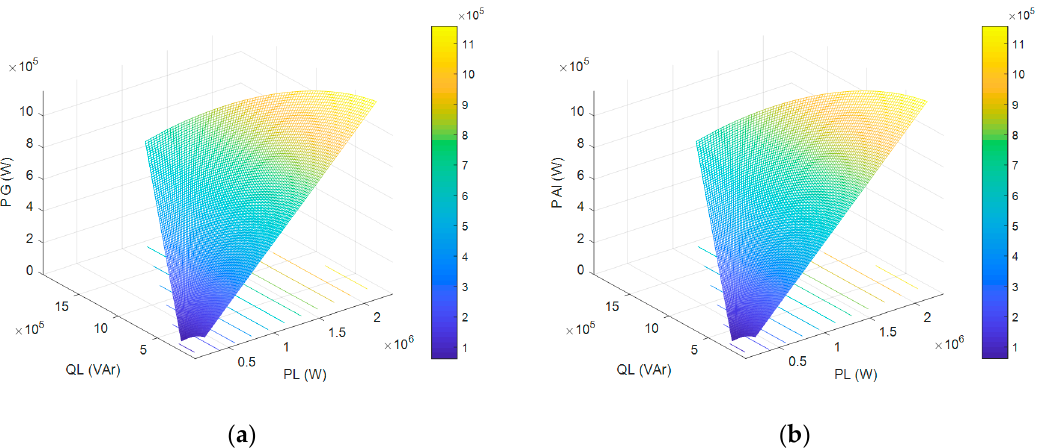
Figure 10. ( a ) Active power diagram in the EESG for k = 0.5. ( b ) Active power diagram in SGAR+AI for k = 0.5.